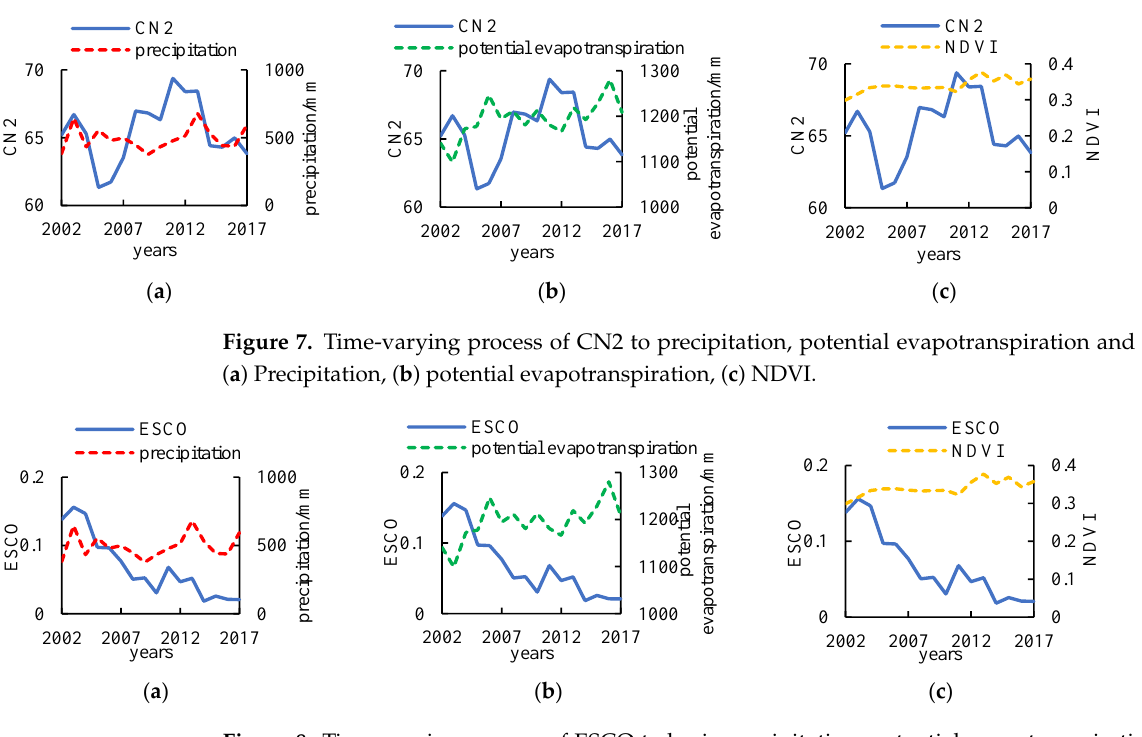
Figure 8. Time-varying process of ESCO to basin precipitation, potential evapotranspiration and NDVI. ( a ) Precipitation, ( b ) potential evapotranspiration, ( c )